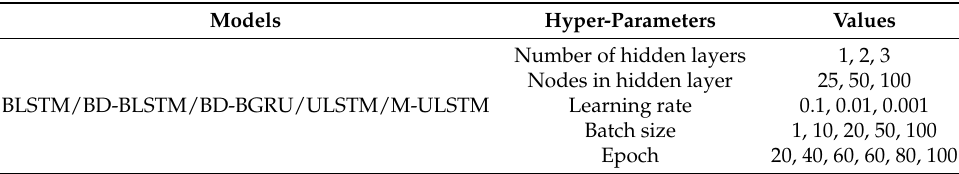
Table 4. Hyper-parameters to